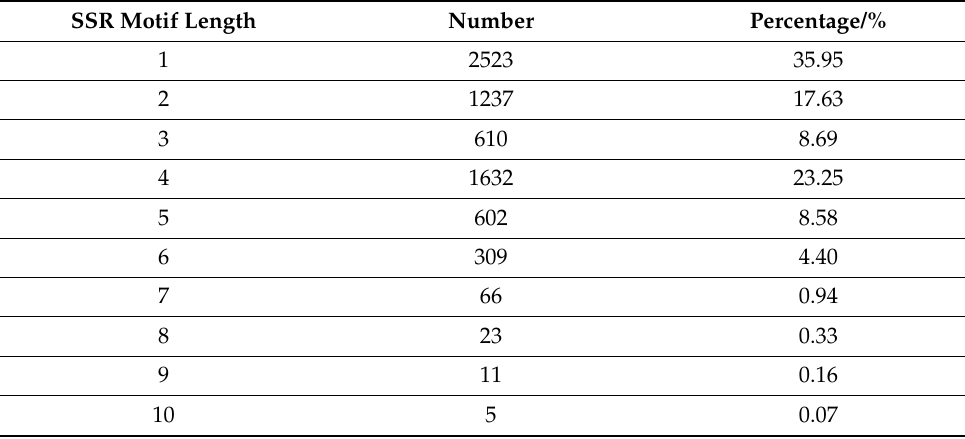
Table 2. The distribution of SSRs types in 160 SPX